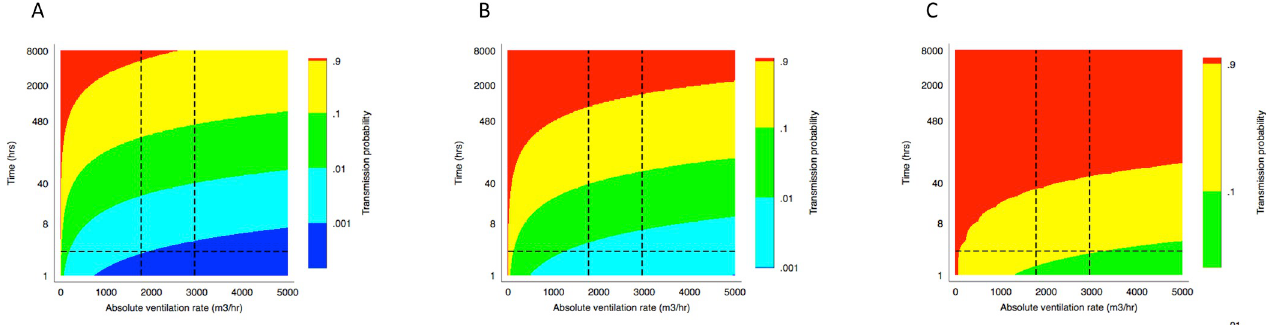
Fig 7. A set of heat maps translating ventilation rate into transmission risk, as estimated using the Wells-Riley equation at 1.25 (A), 8.2 (B) and 226 (C) quanta/ hr. The horizontal lines show the median clinic visit duration. The vertical lines show the median absolute ventilation rate in clinic waiting rooms under both usual and ideal